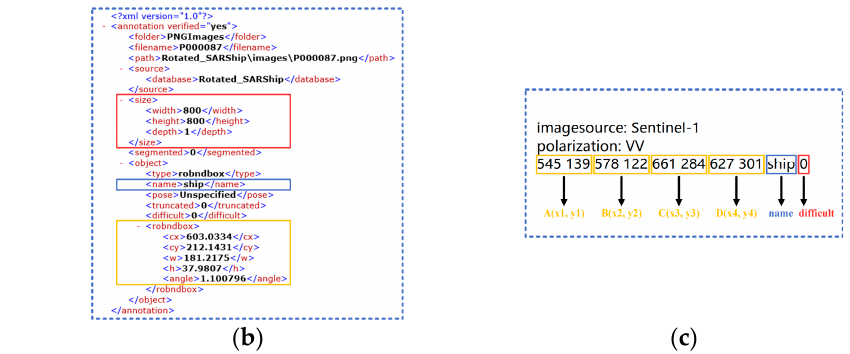
( b ) Figure 14. AIS query and Google Earth correction (take No.1 Sentinel-1 image as an example). ( a ) AIS information of the coverage. Marks of different shapes and colors represent different types of